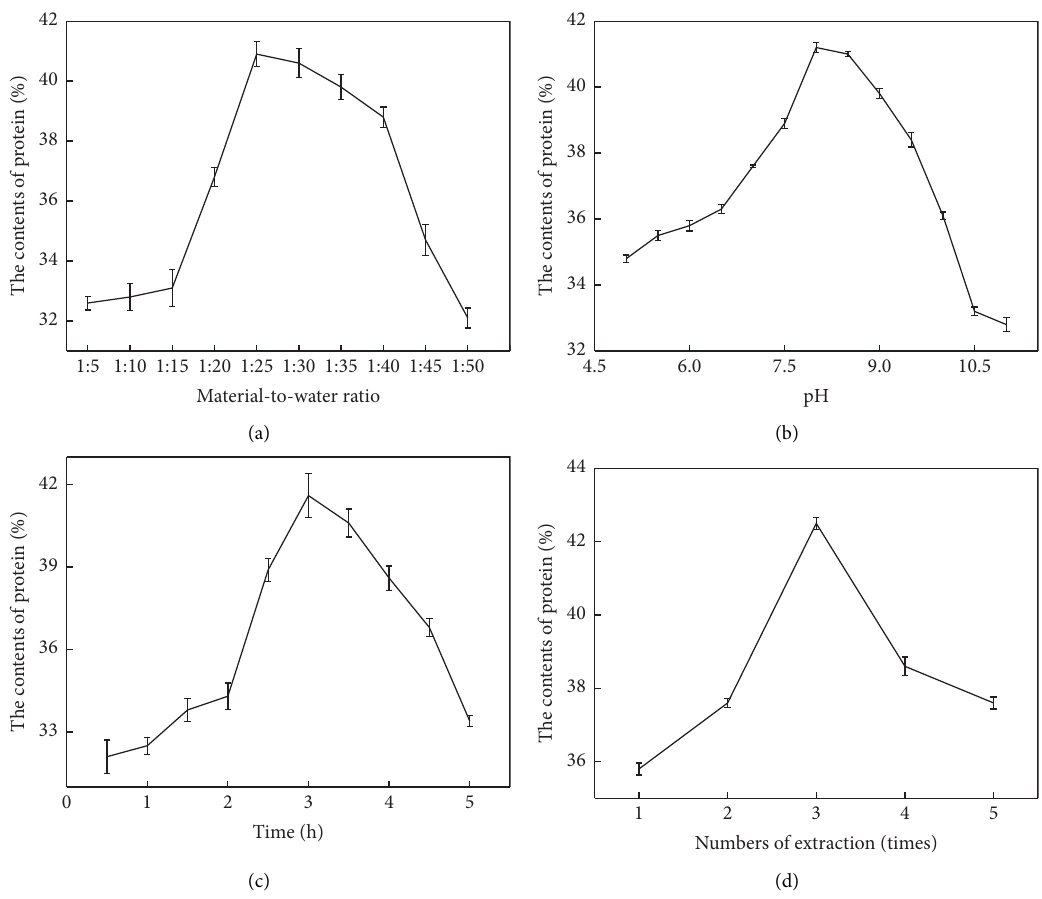
Figure 2: Efect of material-to-water (a), pH (b), time (c), and numbers of extraction (d) on the protein contents. Table 4: Orthogonal optimization results of C. militaris protein